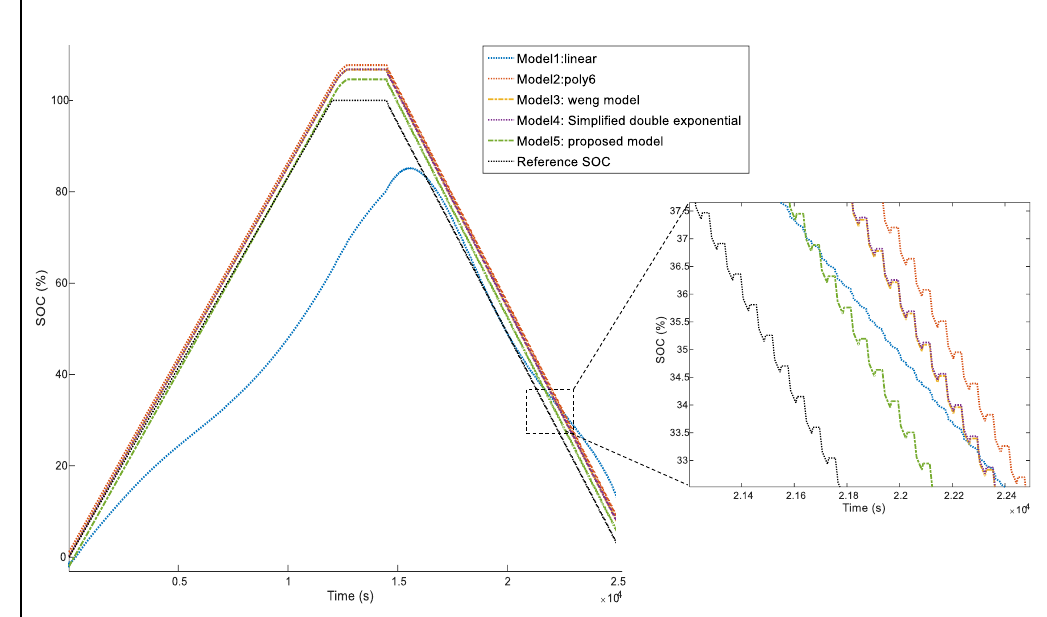
Figure 16. EKF simulation with different OCV models (pulse current load) at 25 ◦ C.